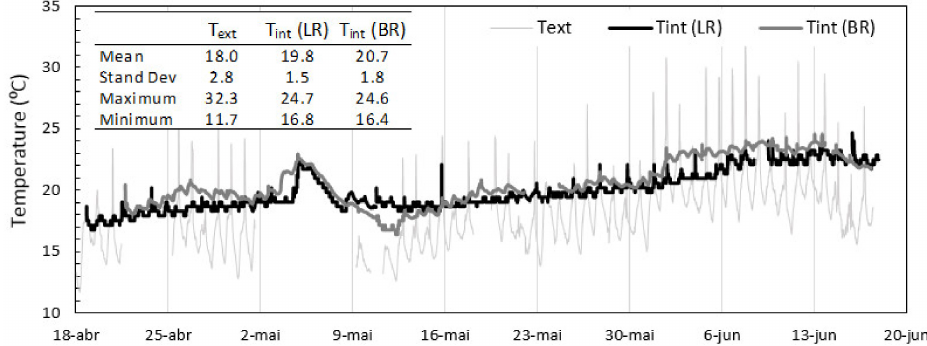
Figure 2. Indoor and outdoor air temperature during the monitoring